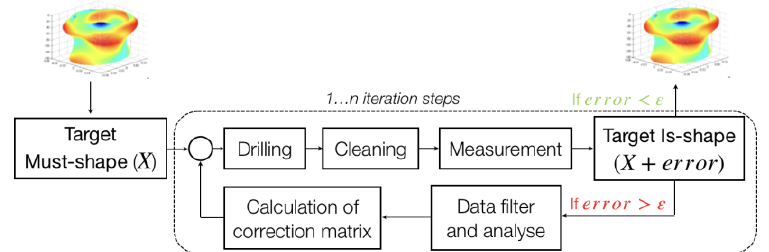
Figure 3. Iterative process: Schematic representation of the iterative incorporation process as a “manual control loop”.